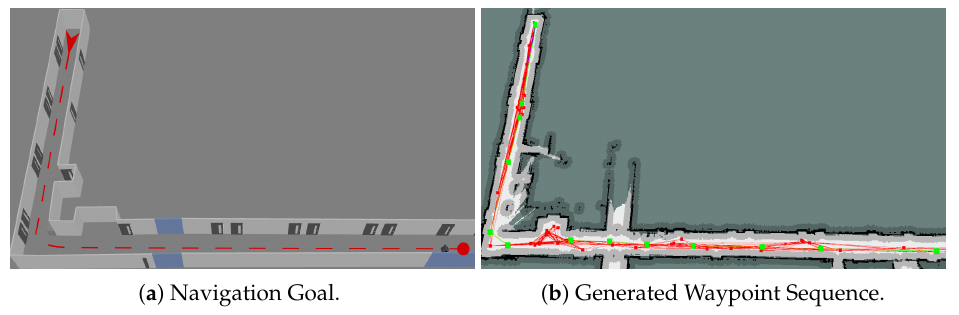
Figure 15. Autonomous navigation experiment. Table 8. Comparison between RL and PRM-RL